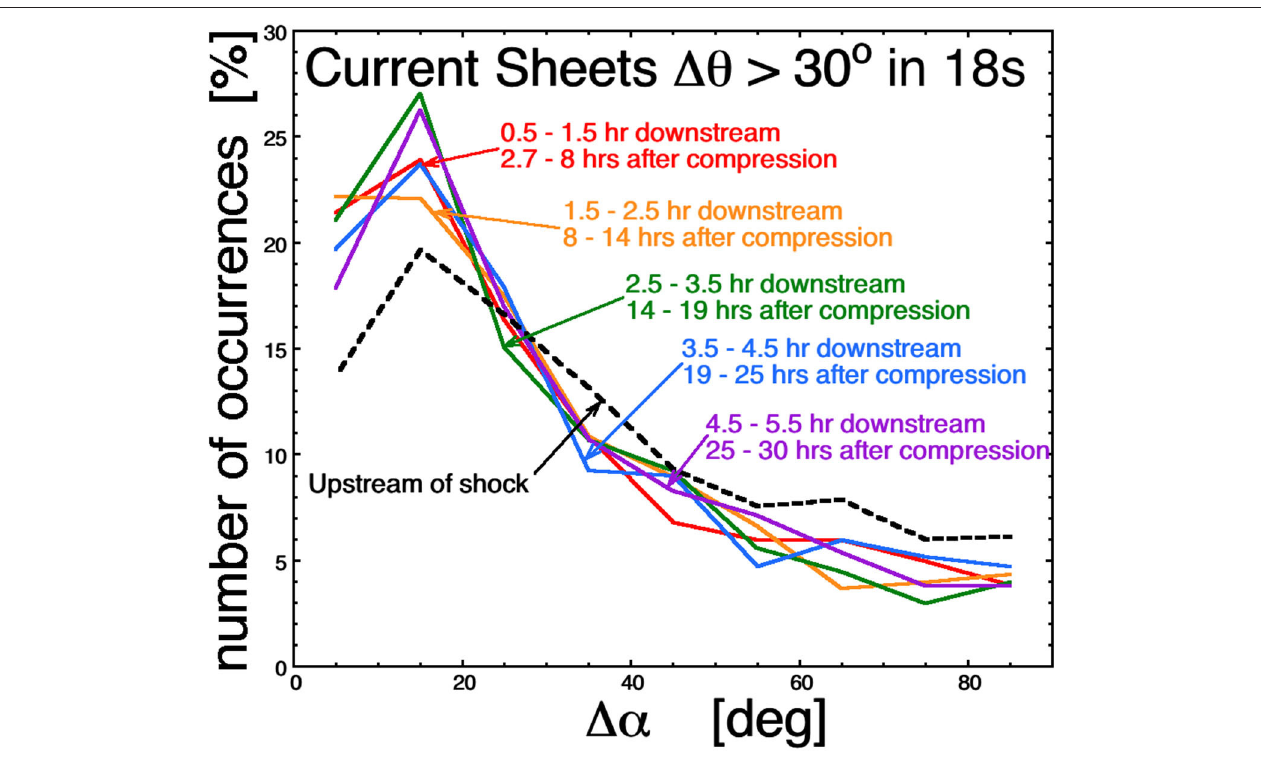
FIGURE 5 | The distributions of change angles 1α are plotted at different times in the downstream plasmas (colors) and compared with the distribution of 1α values in the upstream plasmas (black). downstream the mean value of 1 α is 29.6 ◦ and the median